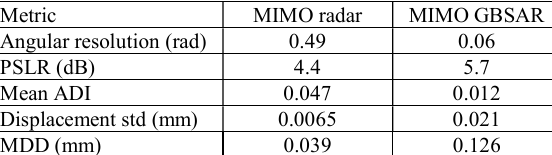
Table 2. Quantitative comparison of MIMO radar and MIMO GBSAR TS interferometric